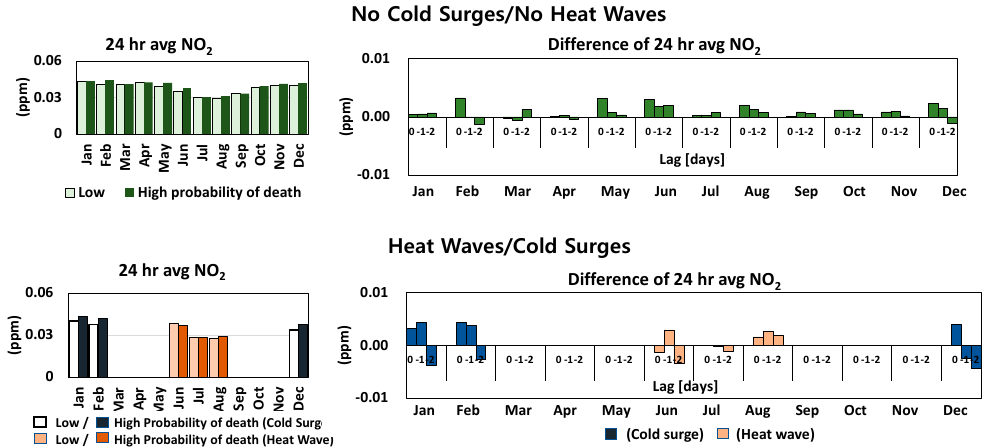
Figure 10. Comparison of monthly average NO 2 levels on days of high and low probability of death and the differences in NO 2 (NO 2 (high probability of death) –NO 2 (low probability of death) ) from zero to two days before death.